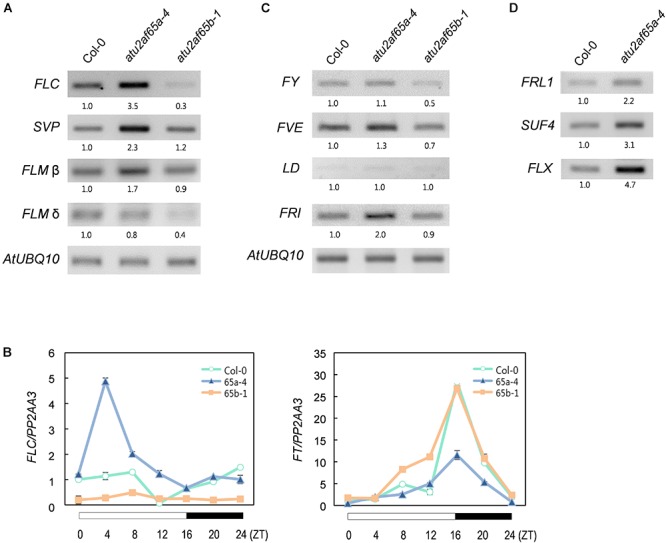
Expression of flowering time genes in the atu2af65a and atu2af65b mutants. (A) RT-PCR analysis of FLC, FLM, and SVP expression in the atu2af65a-4 and atu2af65b-1 mutants grown at 23°C under LD conditions. AtUBQ10 expression served as a loading control. The numbers below the gels denote the fold change relative to wild-type (Col-0) plants. (B) RT-qPCR analysis of FLC and FT expression in the atu2af65a-4 and atu2af65b-1 mutants grown at 23°C under LD conditions. PP2AA3 expression served as a loading control. The error bars indicate the SEM of three biological replicates consisting of independently harvested samples, with technical replicates for each sample. (C) RT-PCR analysis of FY, FVE, LD, and FRI expression in the atu2af65a-4 and atu2af65b-1 mutants grown at 23°C under LD conditions. (D) RT-PCR analysis of FRL1, SUF4, and FLX expression in the atu2af65a-4 and atu2af65b-1 mutants grown at 23°C under LD conditions. AtUBQ10 expression was shown in (C).